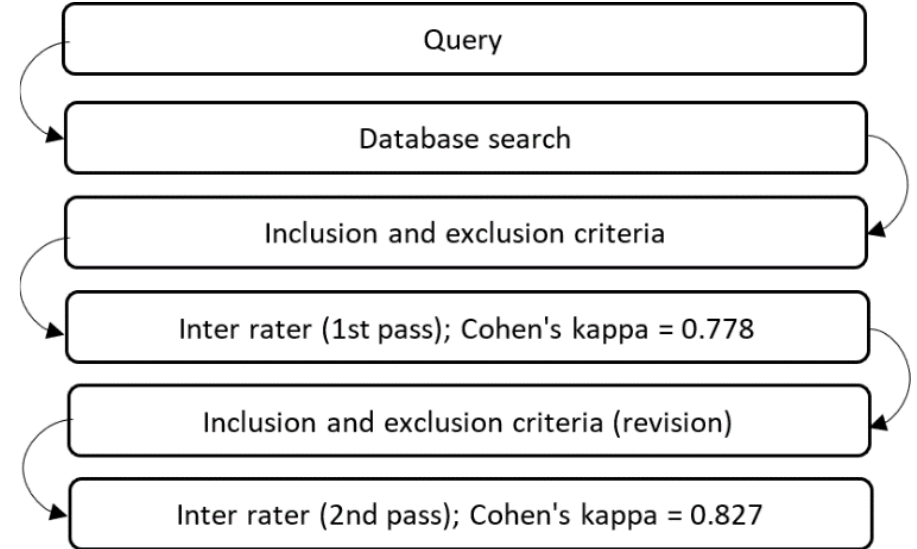
Figure 2. Diagram of the literature review process for the MH dataset.